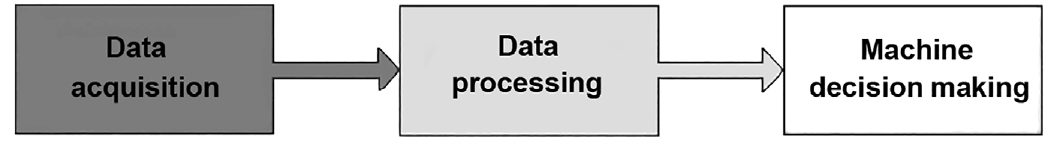
Figure 1. Steps followed to develop a predictive